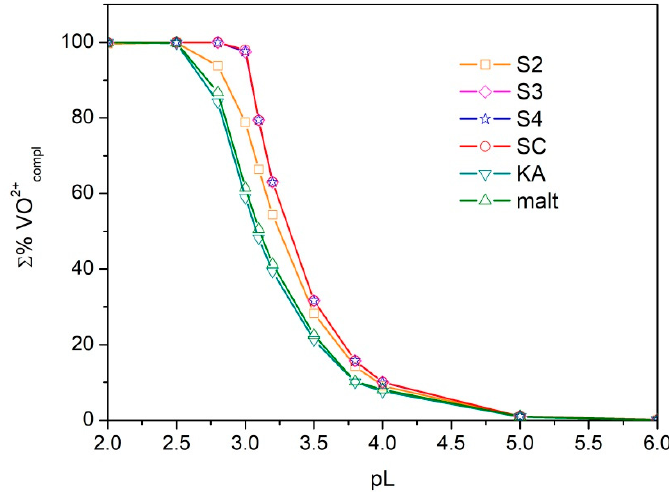
Figure 7. Sequestration diagram. Sum of formation percentages of all metal–ligand species vs. pL values, where L = S2–S4, SC, ka, or maltol. Experimental conditions: I = 0.1 mol L − 1 in KCl, 25 °C, pH = 5.5.